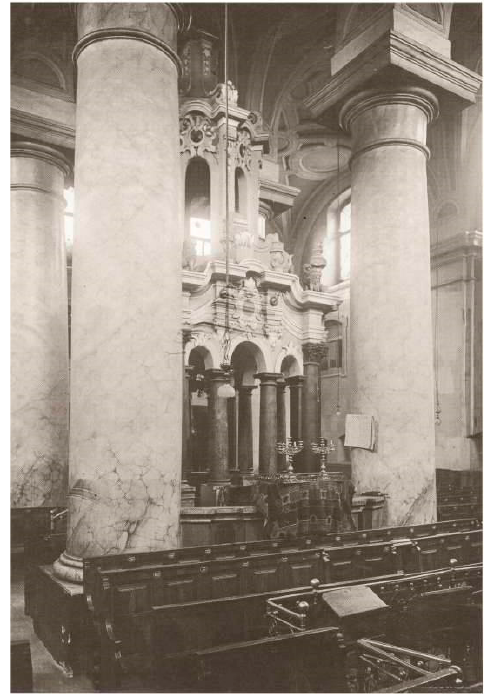
Figure 3. The bimah of the Great Synagogue.